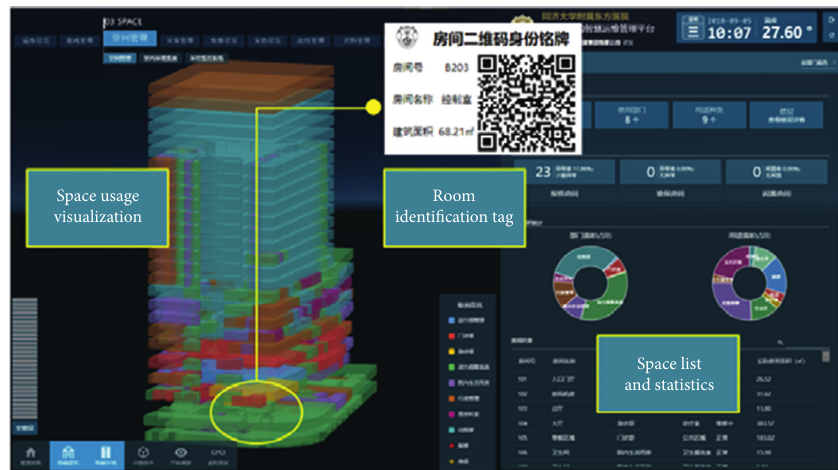
Figure 6: Core functions of space